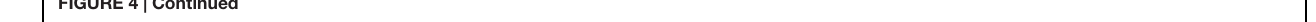
Frontiers in Plant Science |